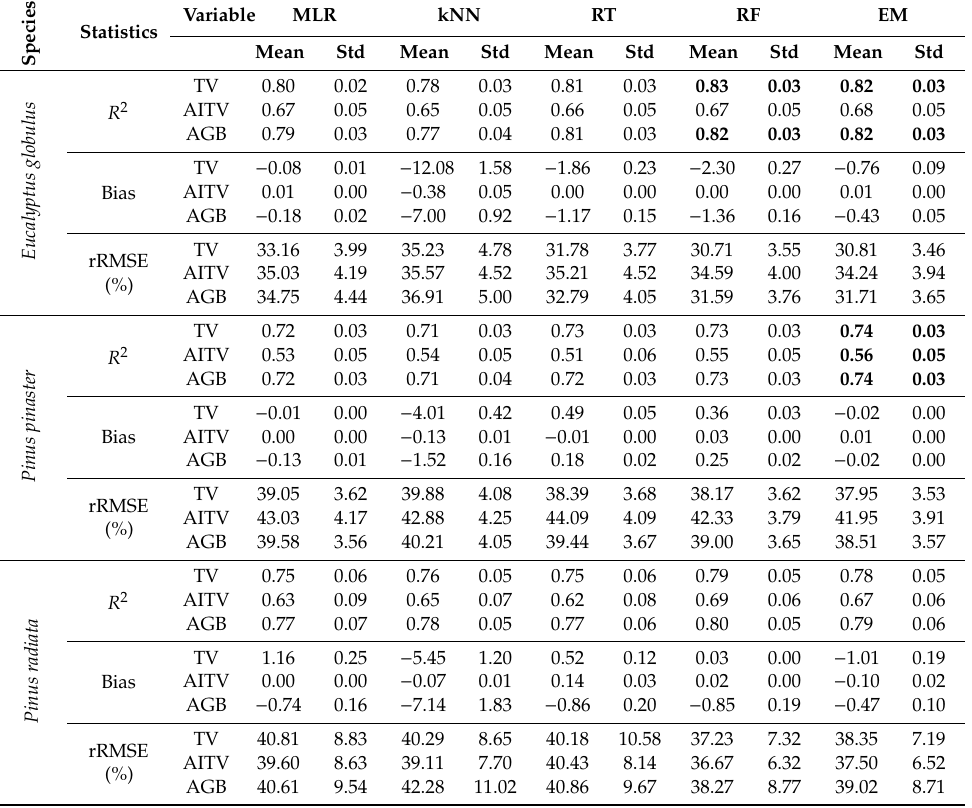
Table 4. Summary of the goodness-of-fit statistics yielded by regression methods for total volume, TV (m 3 / ha), annual increase in total volume, AITV (m 3 / ha year), and total aboveground biomass, AGB (t / ha), for the major commercial tree species in north-western Spain. Methods included Multiple Linear Regression (MLR), k-Nearest Neighbour (kNN), Regression Trees (RT), Random Forest (RF) and the Ensemble method (EM). All values represent the mean and standard deviation (std) of 100 model runs (i.e., 10 replicates, each with 10-fold cross validation). The performance of the regression methods was compared by using di ff erent statistics based on the model errors (mean field values were considered as true values): coe ffi cient of determination ( R 2 ), bias (Bias), the relative root mean square error (rRMSE); and a paired t-test (corrected) based on Student’s t-criterion ( α = 0.05); significantly di ff erences are indicated in bold